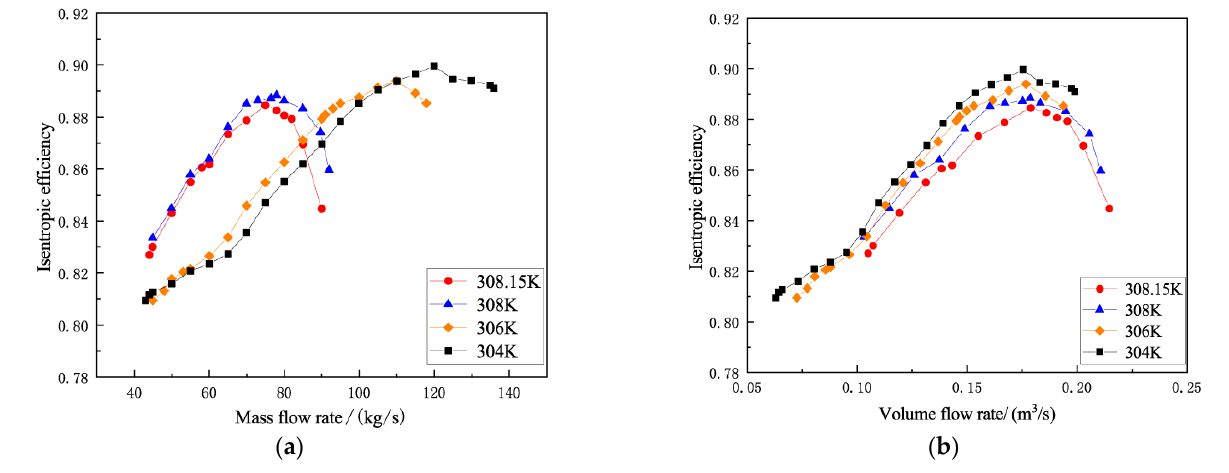
Figure 8. Performance curves at various inlet temperatures. ( a ) Isentropic efficiency versus mass flow rate; ( b ) isentropic efficiency versus volumetric flow rate. rate; ( b ) isentropic efficiency versus volumetric flow